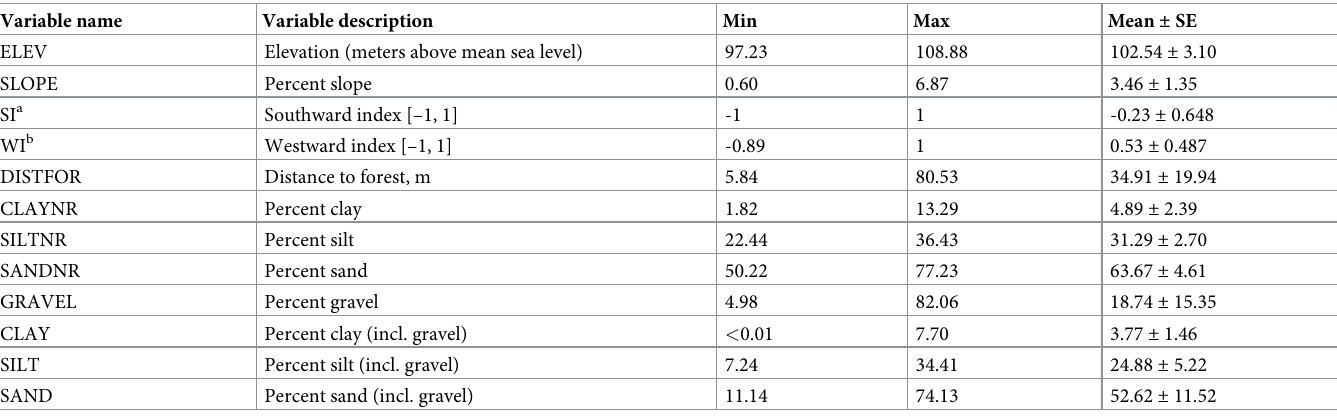
Table 5. Summary of terrain and soil variables, n =